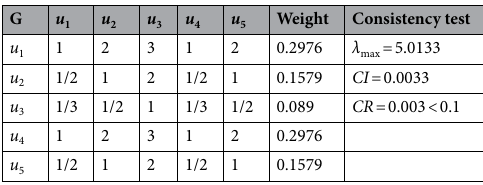
Table 2. The main index layer judgment matrix.